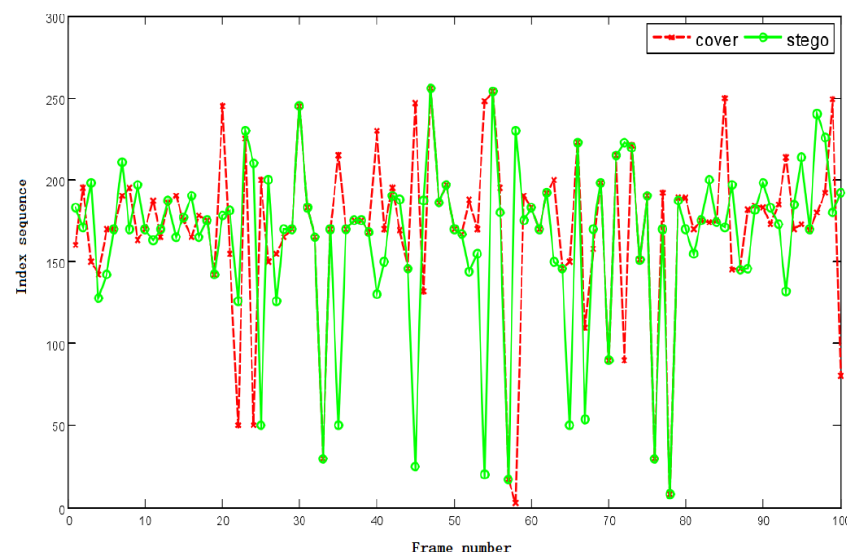
Figure 2. Quantization sequence distribution.